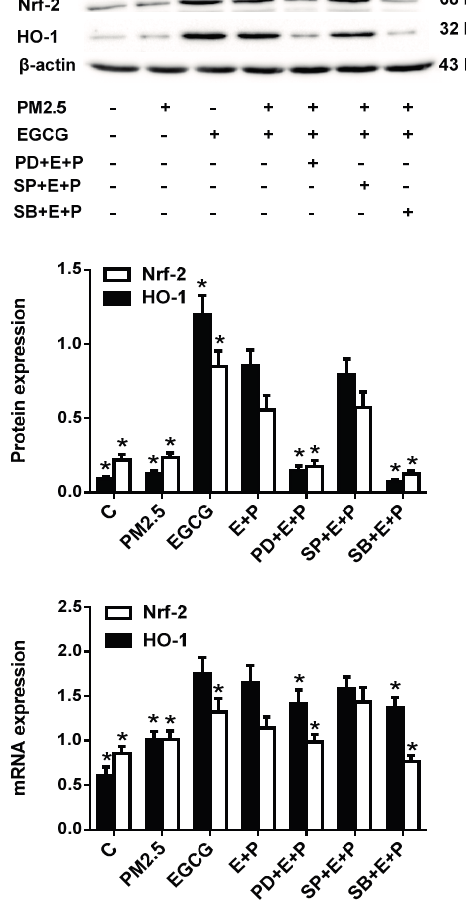
Figure 6. Inhibiting ERK1/2 and p38 MAPK abrogated EGCG-induced Nrf2 and HO-1 expression in PM 2.5 -treated HUVECs. Upper panel: Representative images of Nrf2 and HO-1 expression in HUVECs treated as indicated. C, cultured with medium alone for 24 h; PM 2.5 , incubated with 200 μ g/mL PM 2.5 for 24 h; EGCG, incubated with 100 μ M EGCG for 24 h; E+P, incubated with 100 μ M EGCG and 200 μ g/mL PM 2.5 for 24 h (EGCG was added 30 min before PM 2.5 ); PD+E+P, SP+E+P, and SB+E+P, treated as described for E+P except that the ERK1/2 inhibitor PD98059, the JNK inhibitor SP600125, or the p38 MAPK inhibitor SB203580, respectively was added to the medium before EGCG. Middle panel: Pooled data of Nrf2 and HO-1 protein expression. Lower panel: Pooled data of Nrf2 and HO-1 mRNA expression. Data are expressed as the means ± SEM of three independent experiments. * p < 0.05 vs.